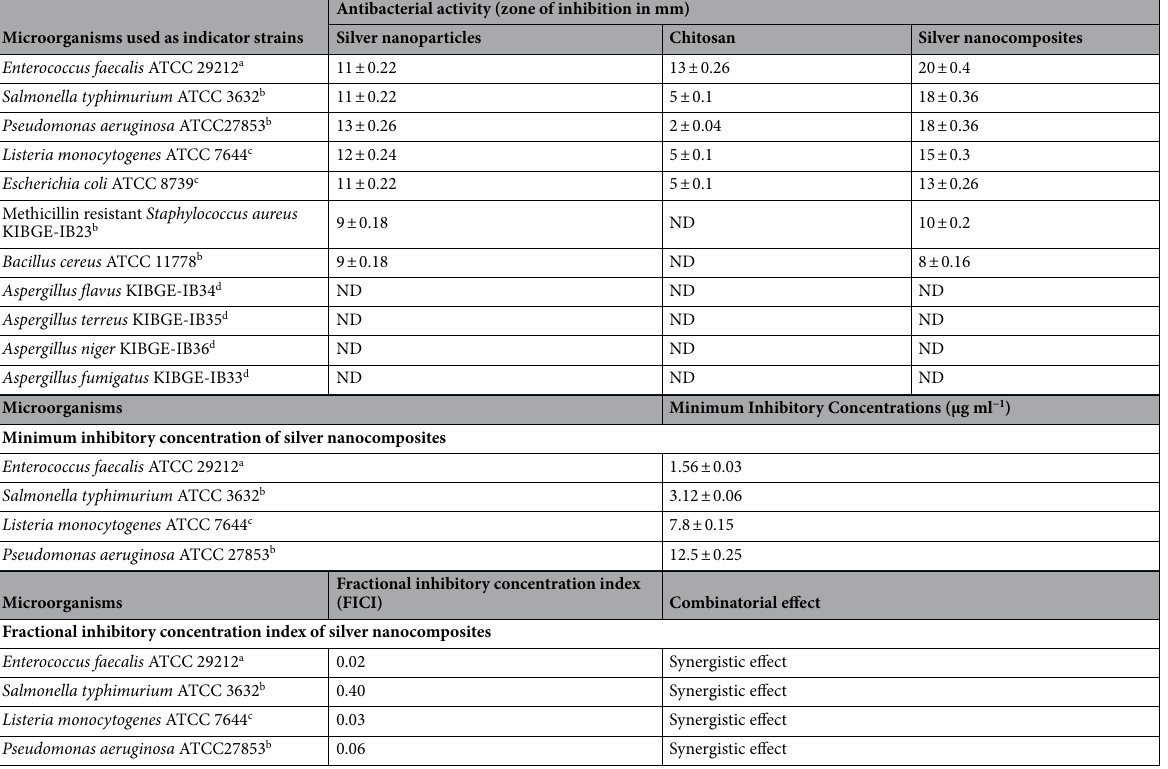
Table 2. Antimicrobial potential of biosynthesized silver nanoparticles and silver nanocomposites along with inhibitory concentrations of silver nanocomposites. ND: Zone of inhibition not detected. a Microorganism was cultivated at 37 °C for 04 h (log-phase) in nutrient broth. b Microorganism was cultivated at 37 °C for 03